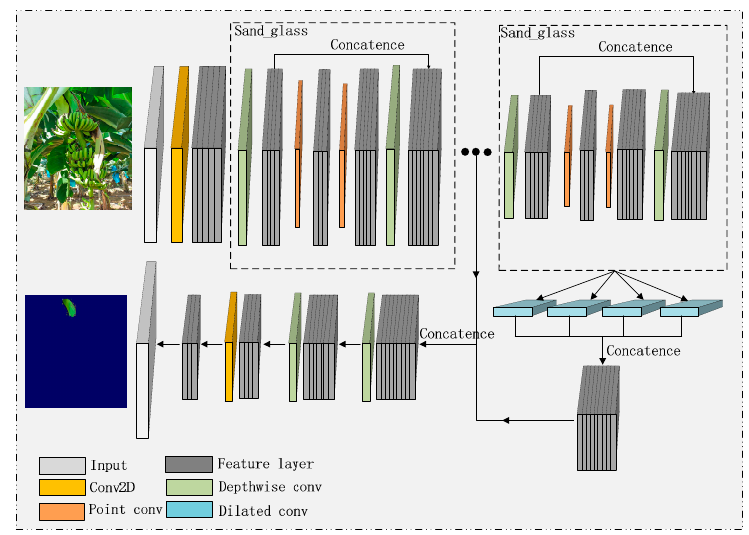
Figure 7. The Sandglass-MFN network model structure.